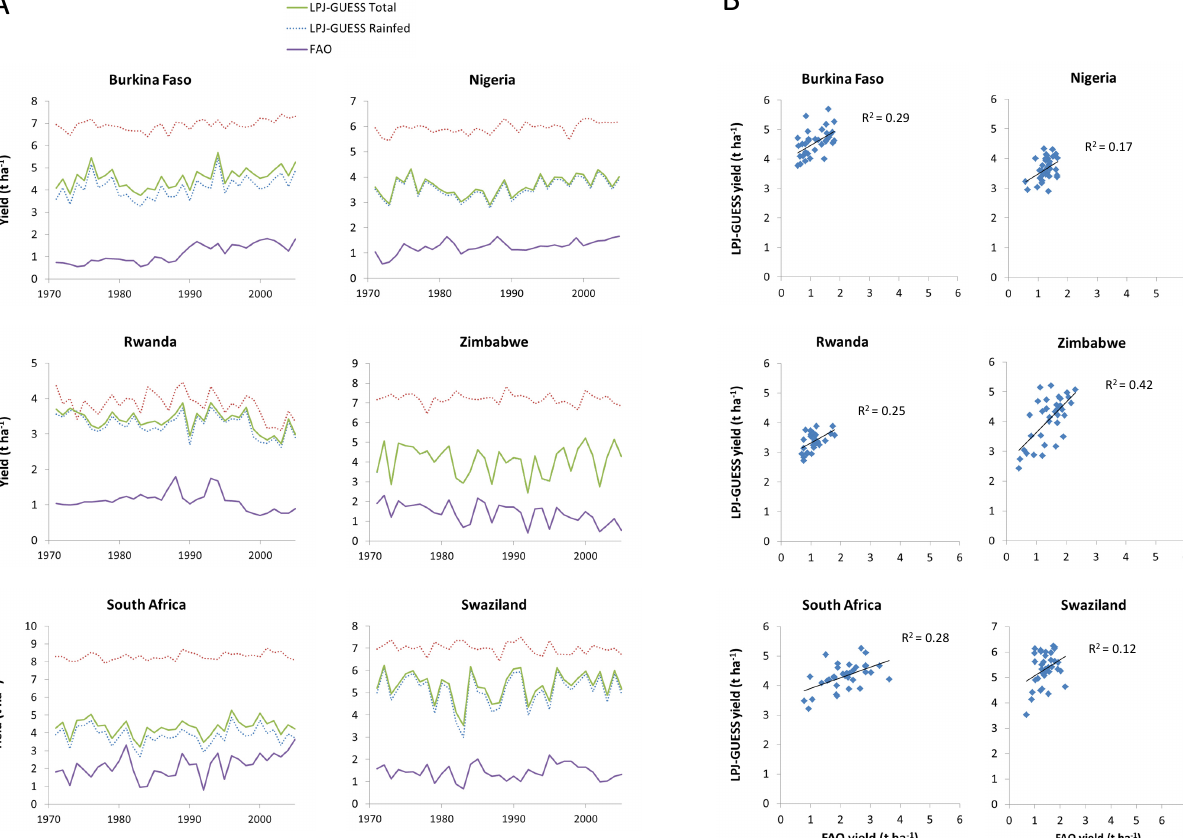
Fig. 9. (A) Time series of LPJ-GUESS modelled irrigated, rain-fed and average yields and reported FAO yields for maize 1971–2005 for selected African countries. (B) Scatter plot of LPJ-GUESS modelled versus FAO reported maize yields 1971–2005 with linear regression lines. Countries were selected that lacked obvious artefacts in the yield interannual data (e.g. constant data and abrupt shifts) and that showed clear correlation with modelled